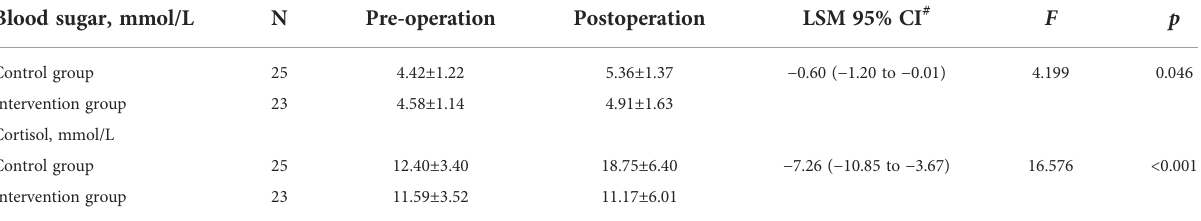
TABLE 3 Blood sugar and cortisol